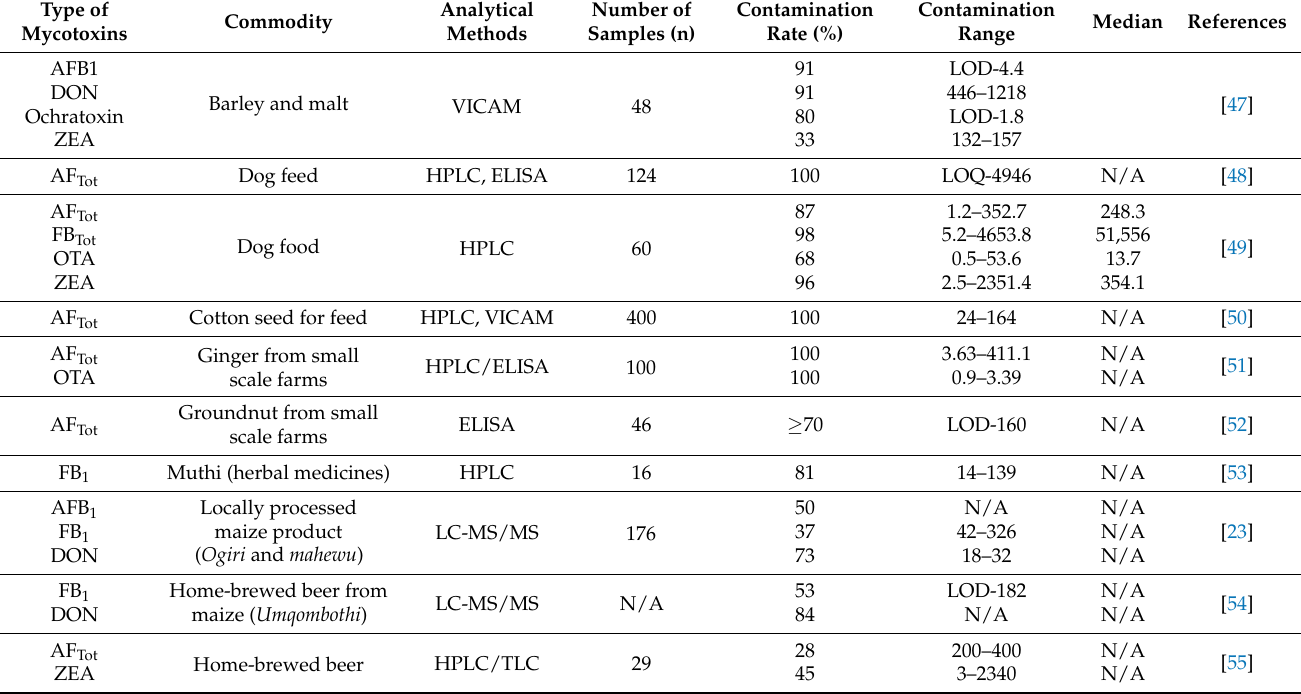
Table 3. Mycotoxin contamination of other foods/feeds from subsistence